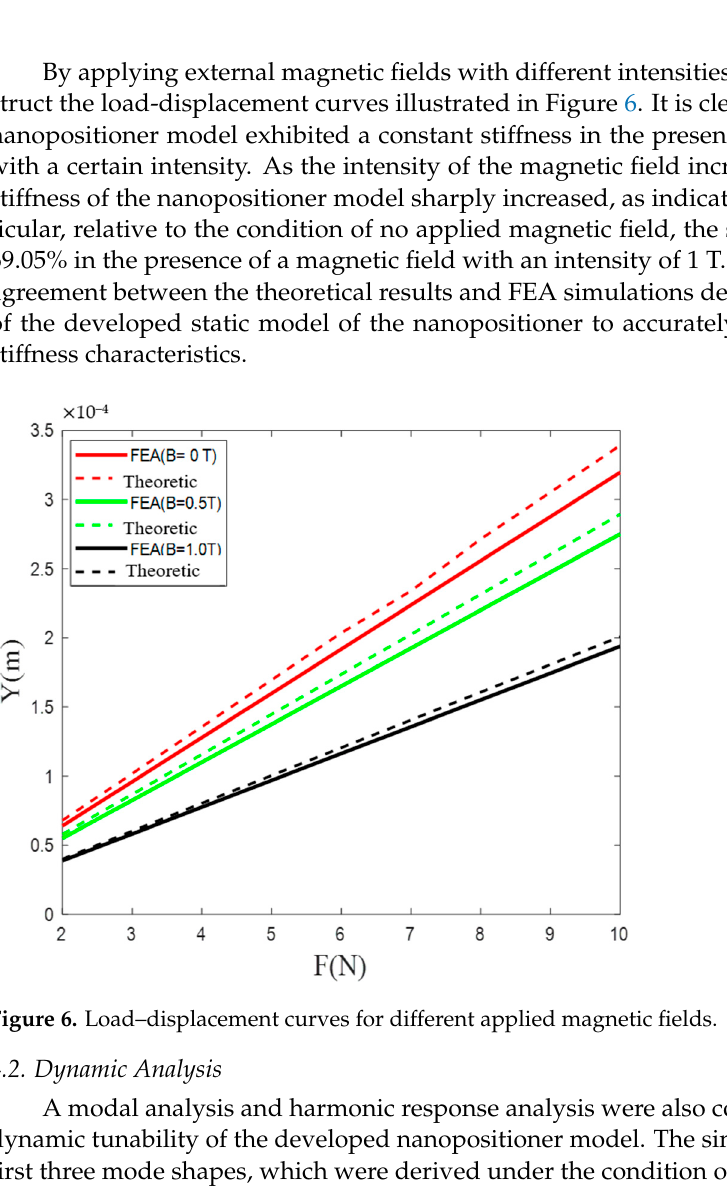
Figure 5. Static analysis results for the micromotion platform: ( a ) Output displacement; ( b ) Strain cloud diagram; and ( c ) Stress cloud diagram.